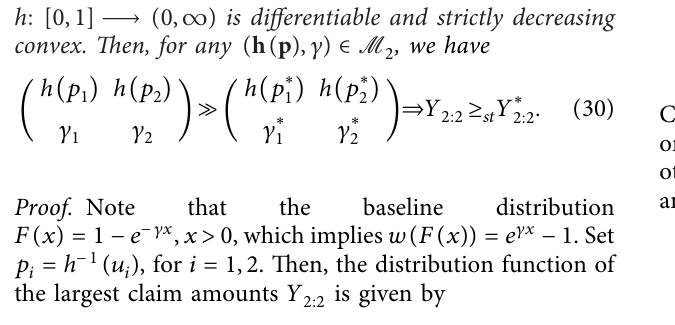
( x ) − F ( x ) . (b) Plot of the difference functions F Y 2 : 2 Y ∗ 2 : 2